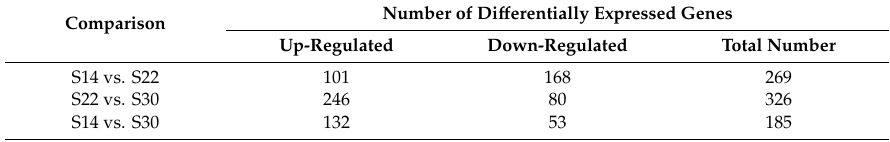
Table 4. Numberofdifferentiallyexpressedgenesof Anadarakagoshimensis